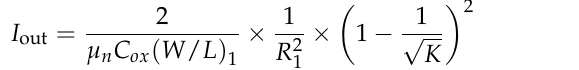
Figure 6. Circuit realization of driver and waveforms of hs_in , gate of PM 10 and NM 16 .